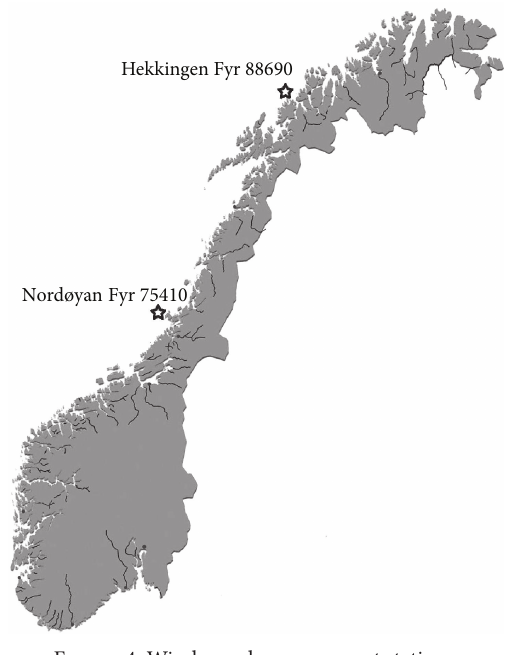
Figure 4: Wind speed measurement stations.